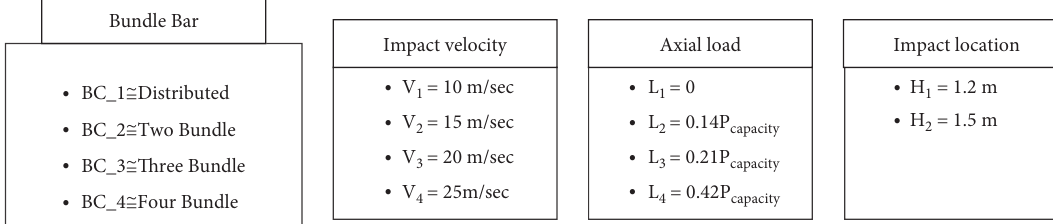
Figure 3: Summary of study parameters.